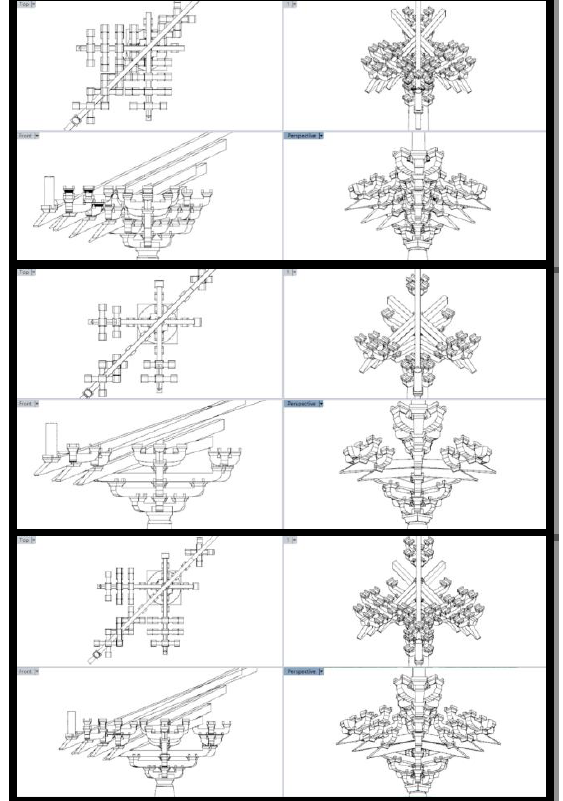
Figure 18. Three variations of bracket